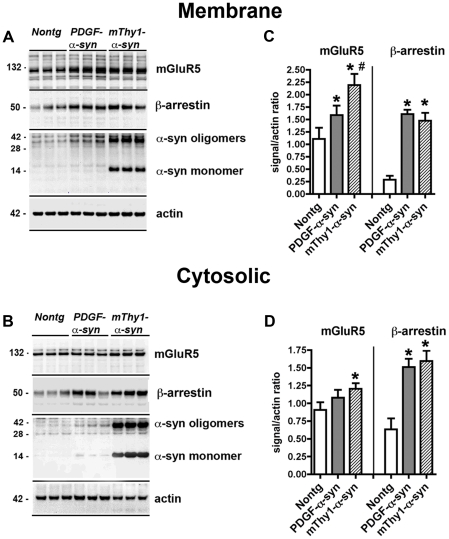
mGluR5, beta-arrestin and alpha-syn expression in frontal cortex of alpha-syn transgenic mice.(A) Representative immunoblot of mGluR5, beta-arrestin and alpha-syn expression levels in the membrane fraction of the frontal cortex from non-tg, PDGF-alpha-syn and mThy1-alpha-syn tg mice. (B) Representative immunoblot of mGluR5, beta-arrestin and alpha-syn expression levels in the cytoplasmic fraction of the frontal cortex from non-tg, PDGF-alpha-syn and mThy1-alpha-syn tg mice. (C) Analysis of mGluR5 and beta-arrestin levels in the membrane fraction of the frontal cortex. (D) Analysis of mGluR5 and beta-arrestin levels in the cytoplasmic fraction of the frontal cortex. * Indicates a significant difference between alpha-syn tg mice and non-tg controls p<0.05, one-way ANOVA and post hoc Fisher). # Indicates a significant difference between PDGF-alpha-syn and mThy1-alpha-syn tg mice (p<0.05, one-way ANOVA and post hoc Fisher)(n = 8 mice per group).